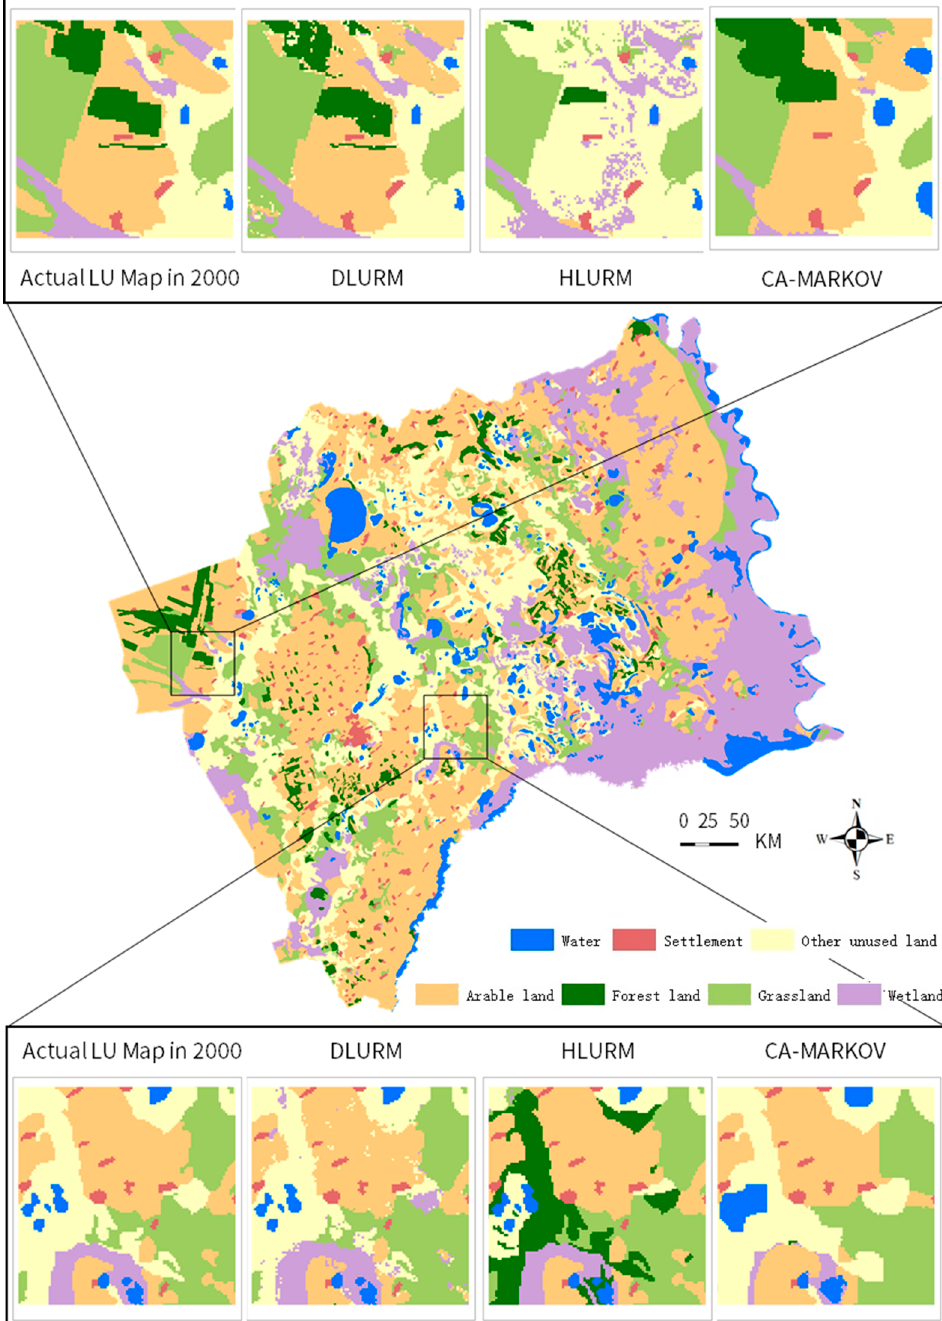
Figure 12. Comparison of simulated results for 2000, using several models of the study area.